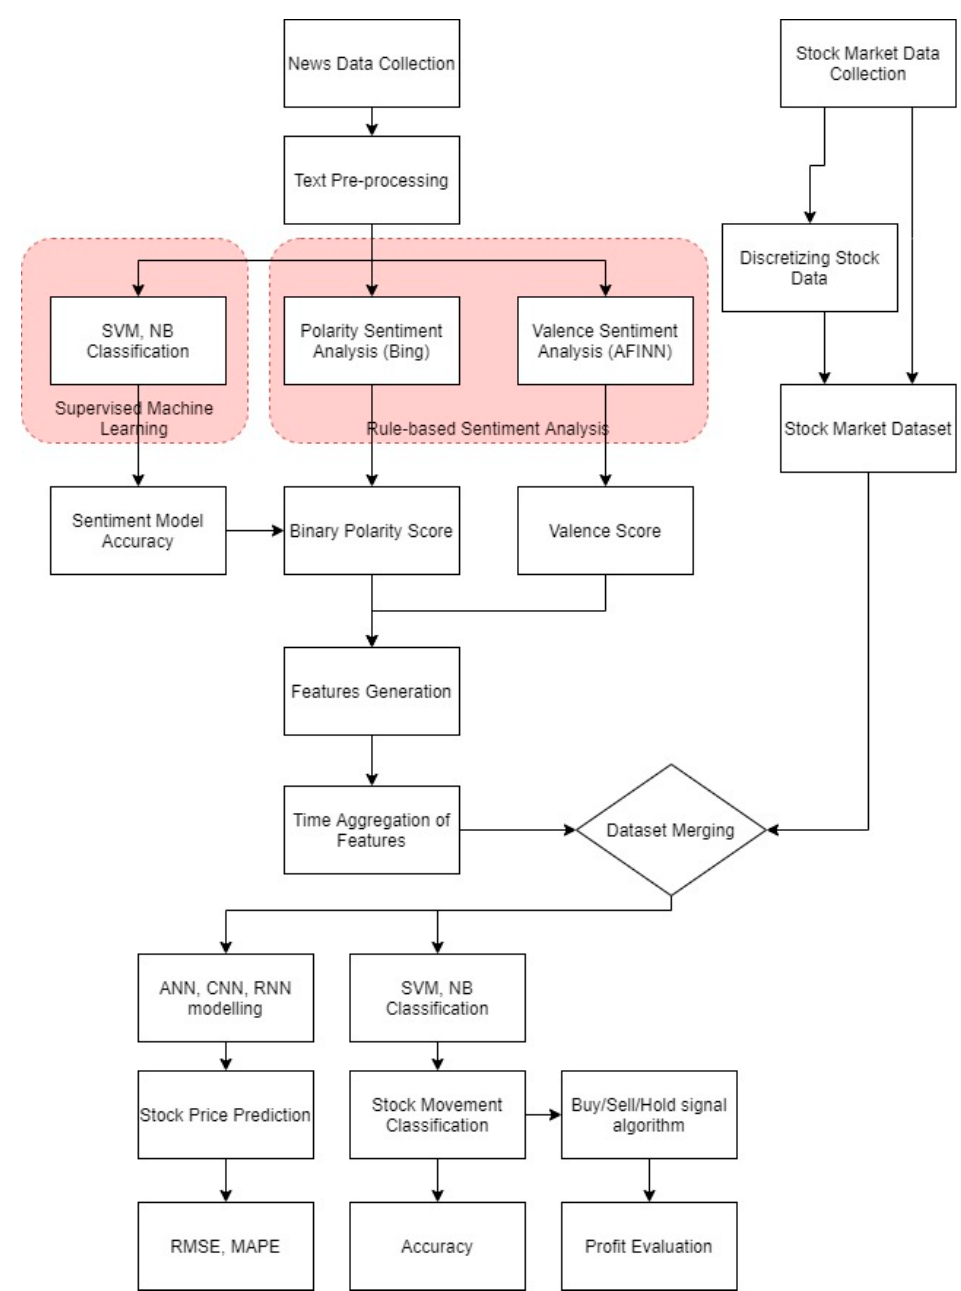
Figure 1. Overall Methodology for Research.